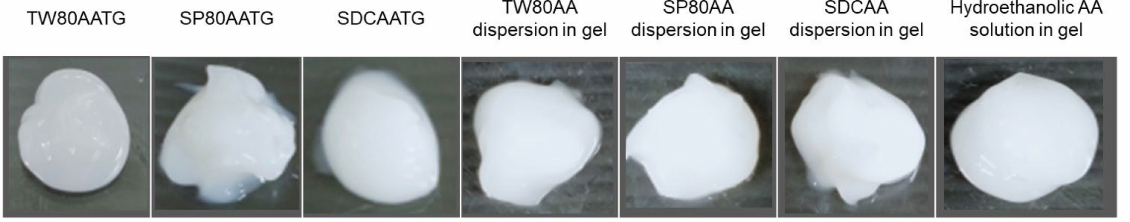
Figure 2. The physical appearance of freshly prepared AATGs and control gels for the in vitro permeation study.